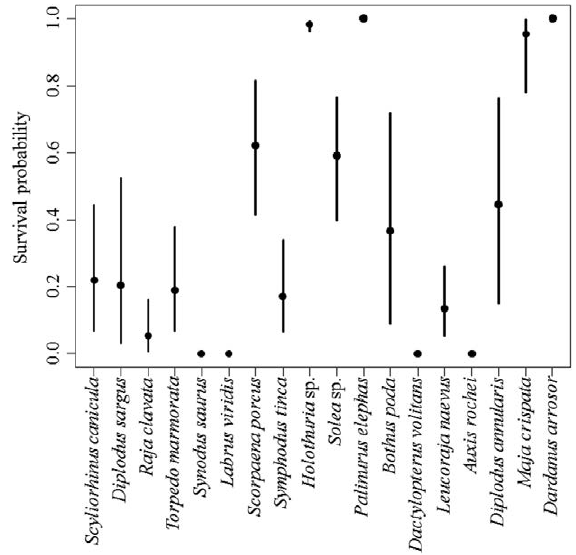
Fig. 6. – Probability of immediate survival (at the moment the gear came on board) of the most discarded species (n>8). The dispersion bar corresponds to 95% Bayesian credibility intervals of survival